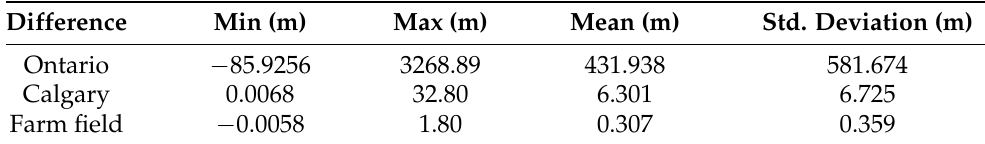
Table 2. Difference in meters between the ArcGIS Pro calculated planar distances and the distances from Algorithm